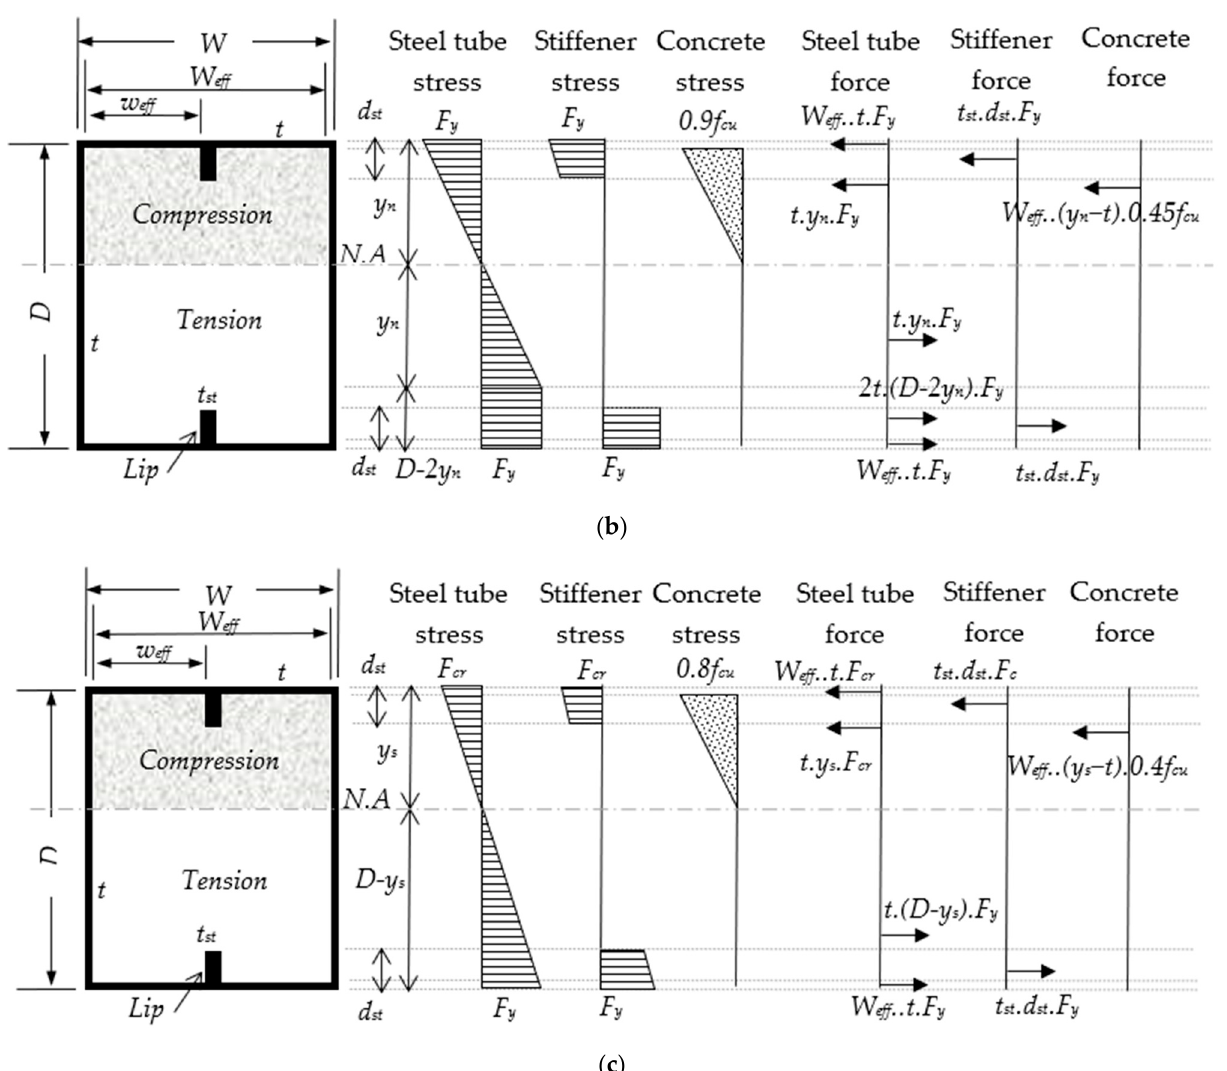
Figure 14. Stress block diagrams of stiffened CFST beam with internal stiffeners: ( a ) compact section; ( b ) non-compact section; ( c ) slender section.